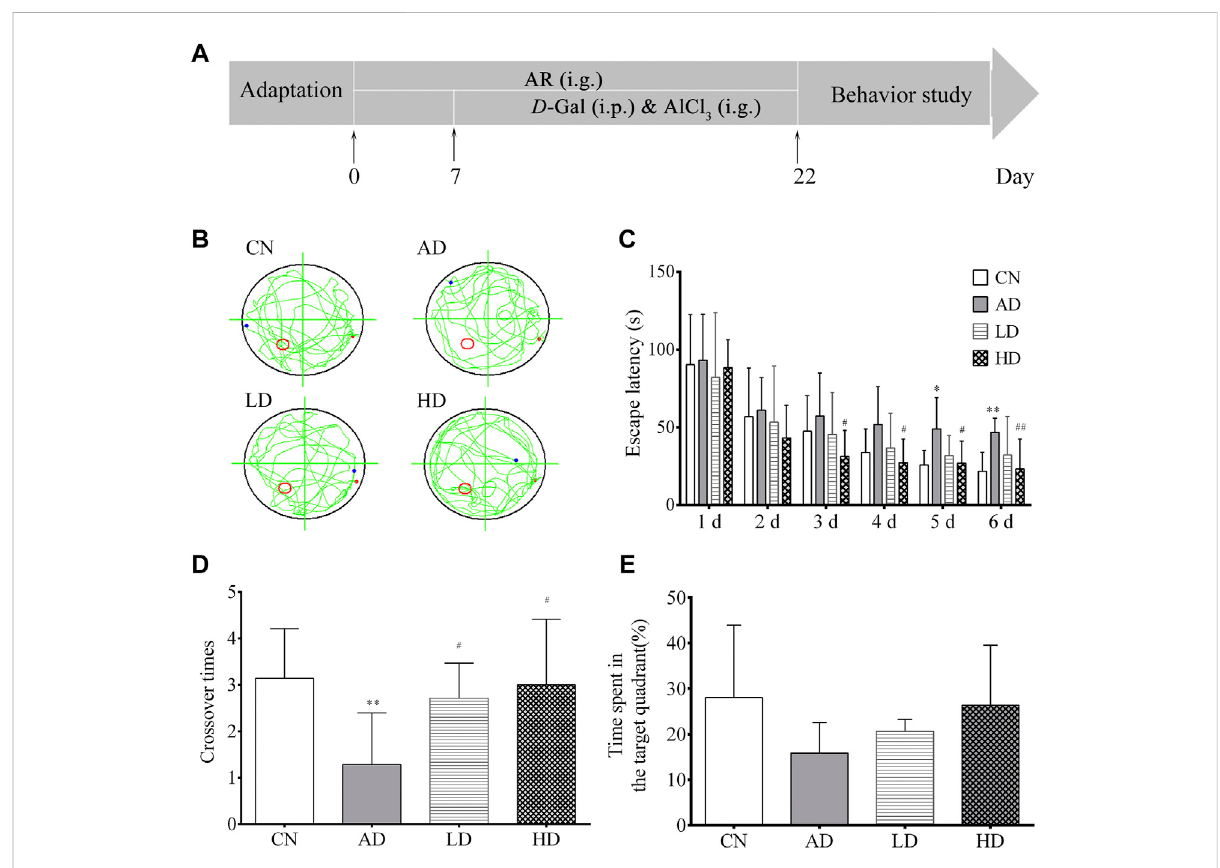
FIGURE 2 Effect of AR on AD model in MWM. (A) Schematic representation of the experimental procedure (B) Abridged general view of rat in testing, (C) Escape latency in location sailing test (D) Crossover times in spatial probe task, (E) Time in the target quadrant in spatial probe task. CN, the blank control group, AD, the AD model group, LD, the AR treatment group of low dosage (LD), HD, and the AR treatment group of high dosage (HD).* p < 0.05, ** p < 0.01, compared with CN group; # p < 0.05, ## p < 0.01, compared with AD